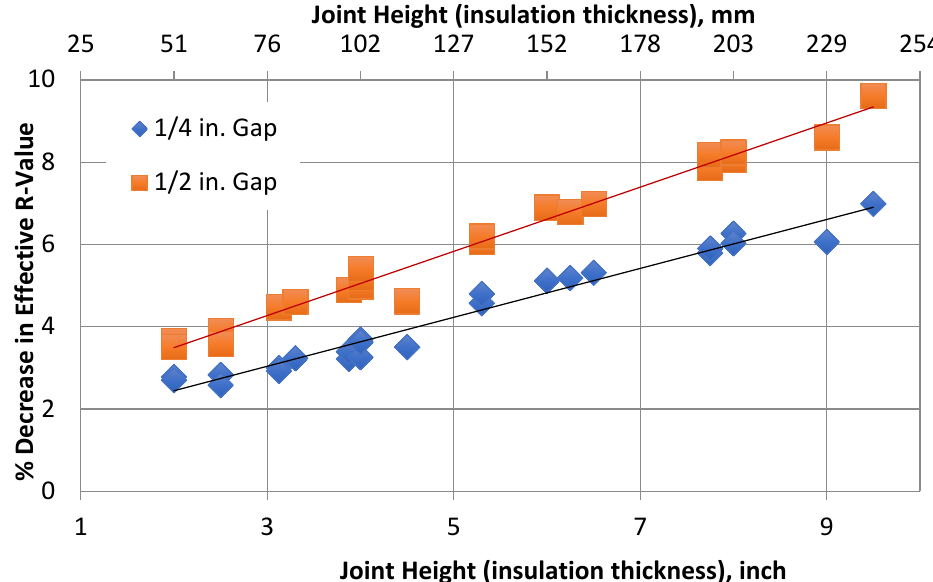
Figure 6. Gap Impact Factor for Top Joint, Bottom Joint, and 610 mm [24 in] Staggered Joint Configurations.